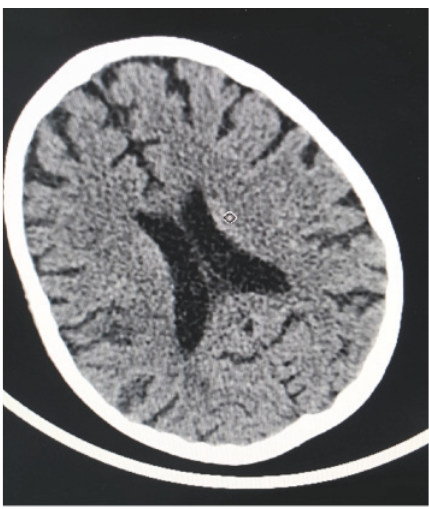
Figure 1: Patient CT scan showing showed small hypodensity foci situated in the cortical and subcortical area in right partial lobe.